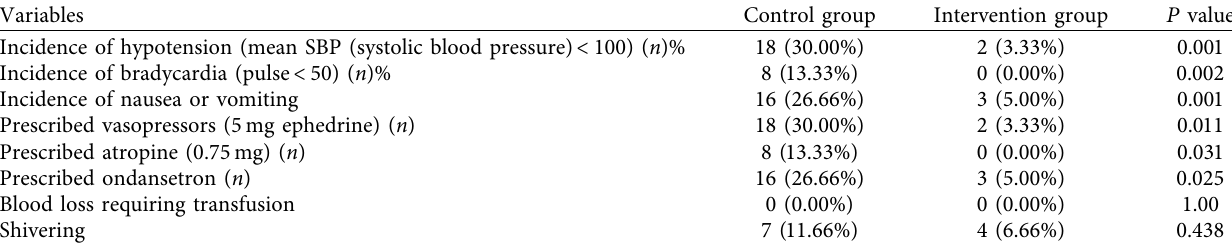
Figure 3: Mean heart rate variation in both groups. Table 4: Te incidence of study complications in both